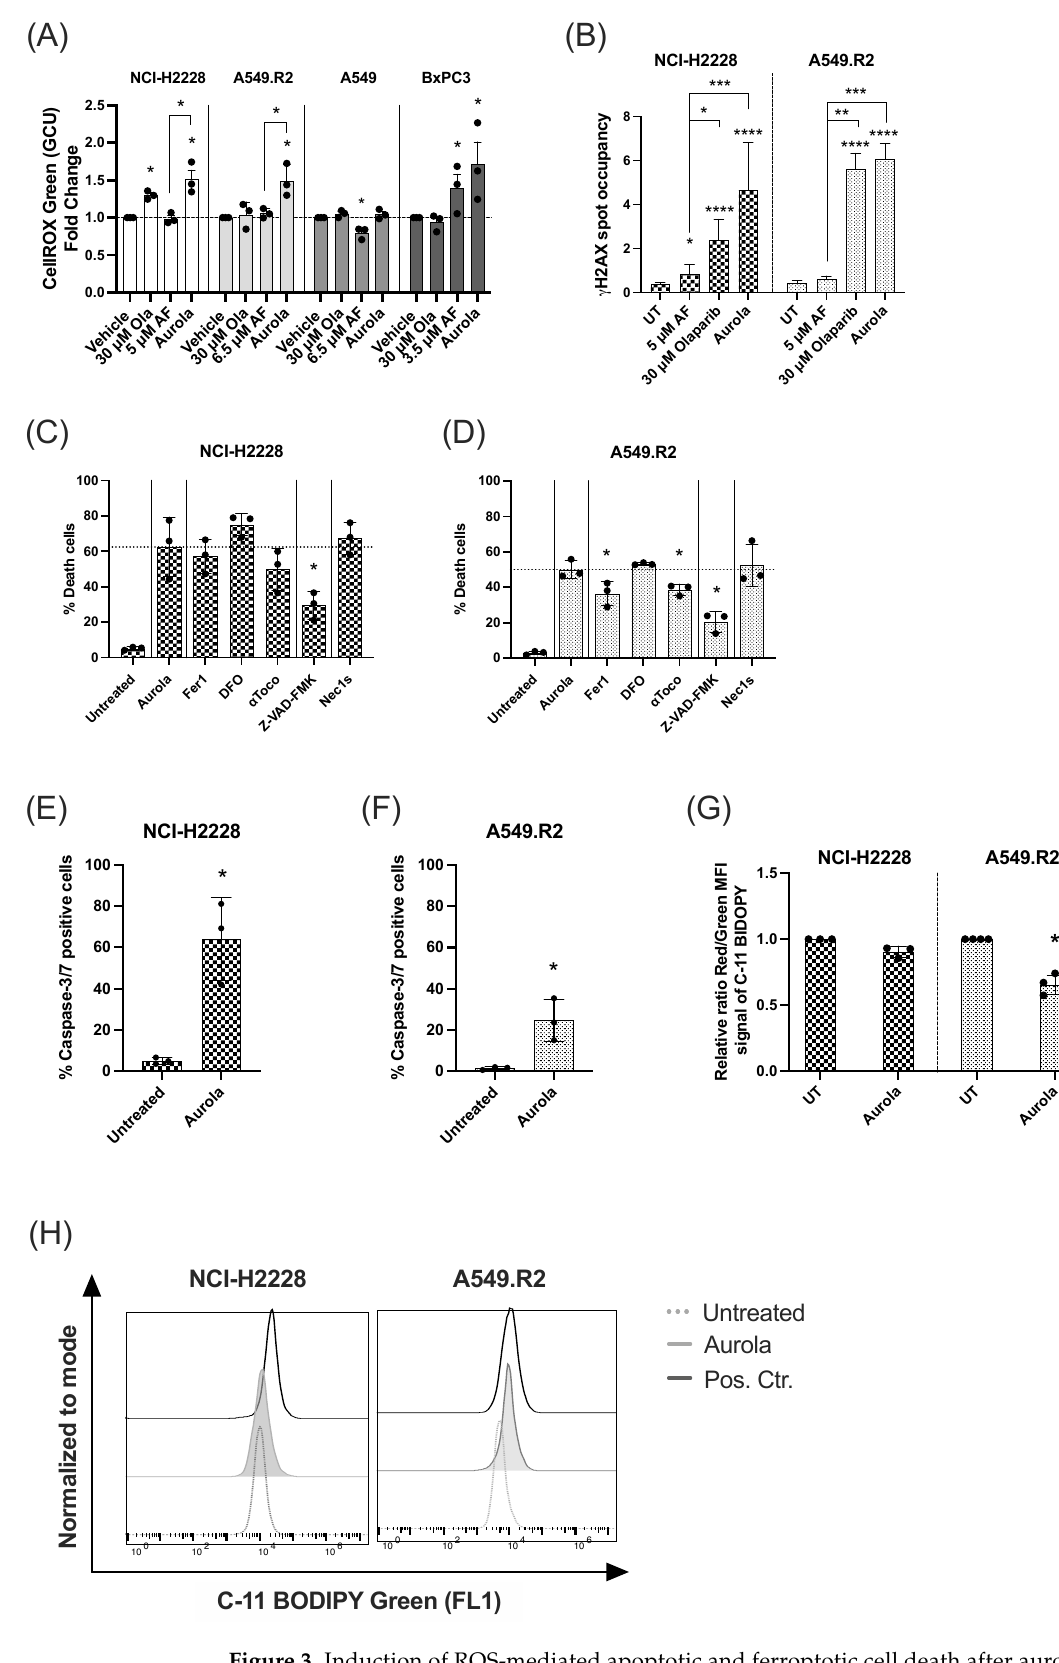
Figure 3. Induction of ROS-mediated apoptotic and ferroptotic cell death after aurola treatment of mutant p53 NSCLC cells. ( A ) Intracellular ROS levels shown as fold change of the CellROX